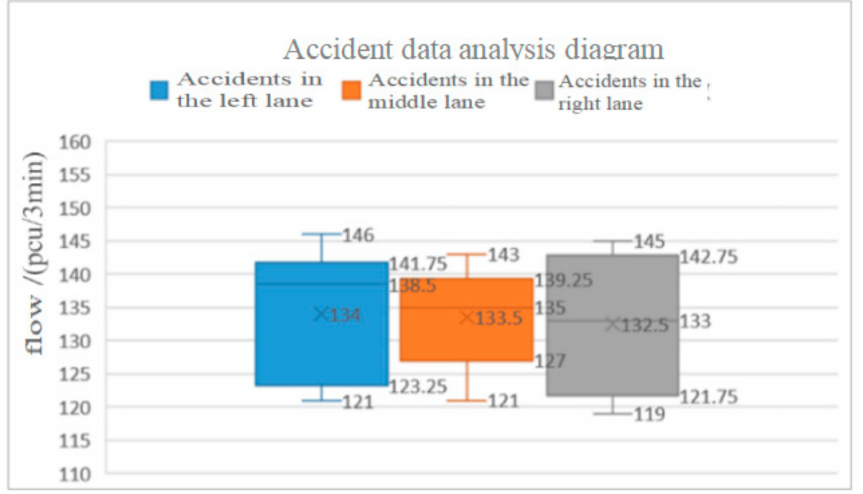
Figure 14. Accident data analysis diagram for one-way three lane on one